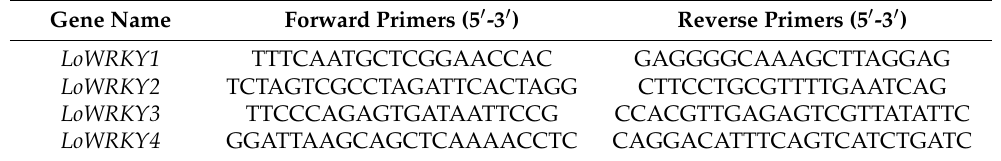
Table 3. Real-time fluorescence quantitative PCR reaction system. Table 2. The primers used in real-time RT-PCR.